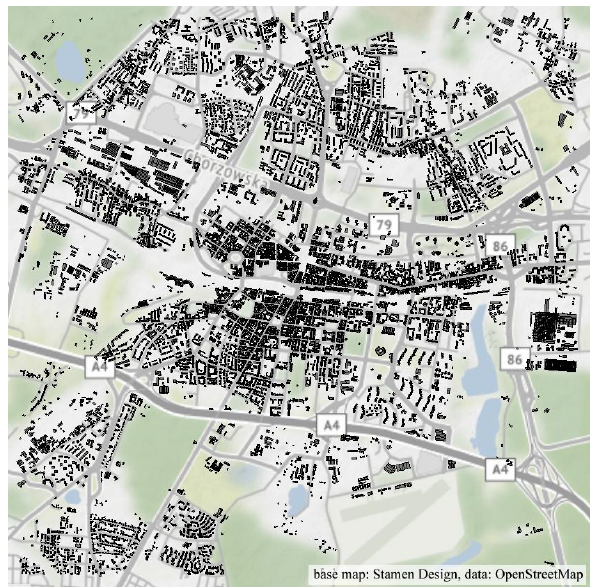
Figure 7. A fragment of the city model, 5x5 km including 10,301 buildings.